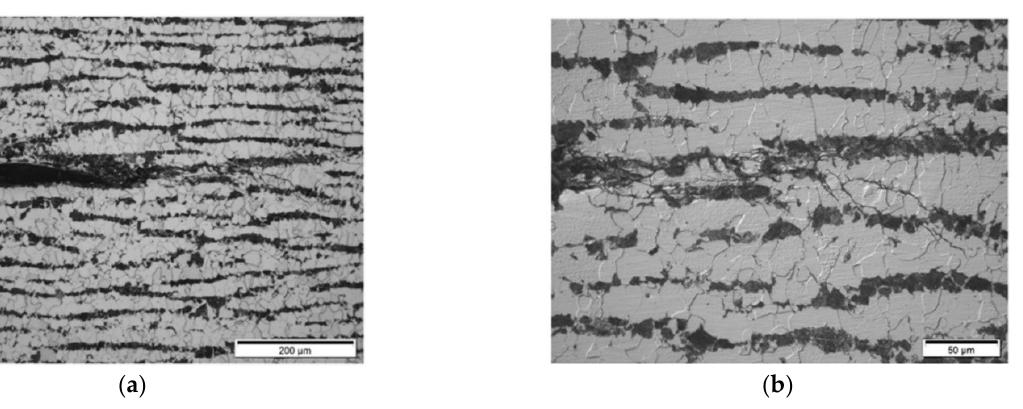
Figure 22. Section No2: 90–140. Coordinate 120 mm, 6.2 mm from ID. Isolated HIC blister, magnifi- cation 200× ( a ), 1000× ( b ).